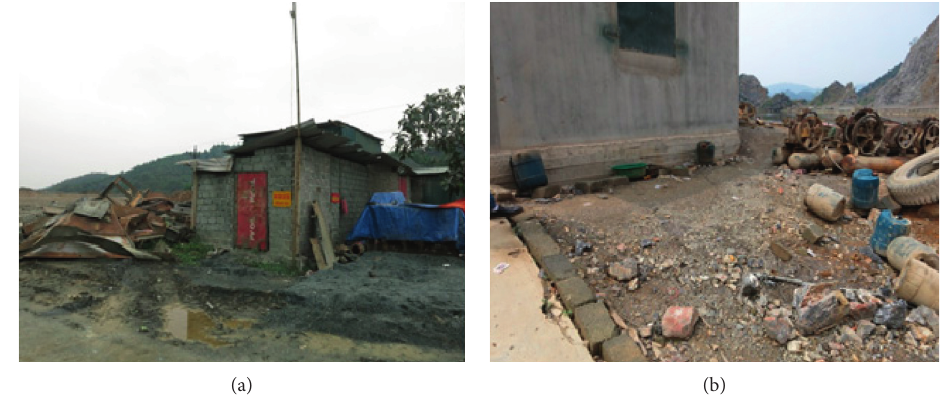
Figure 6: Sampling point in warehouse area (warehousing including hazardous